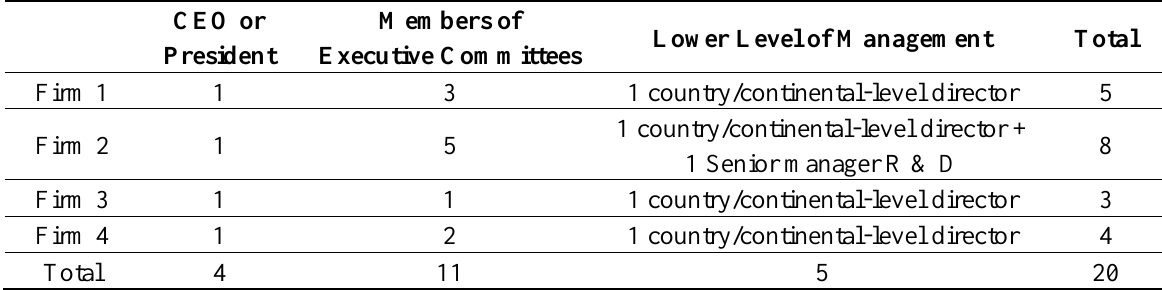
Table 1. Position occupied by managers